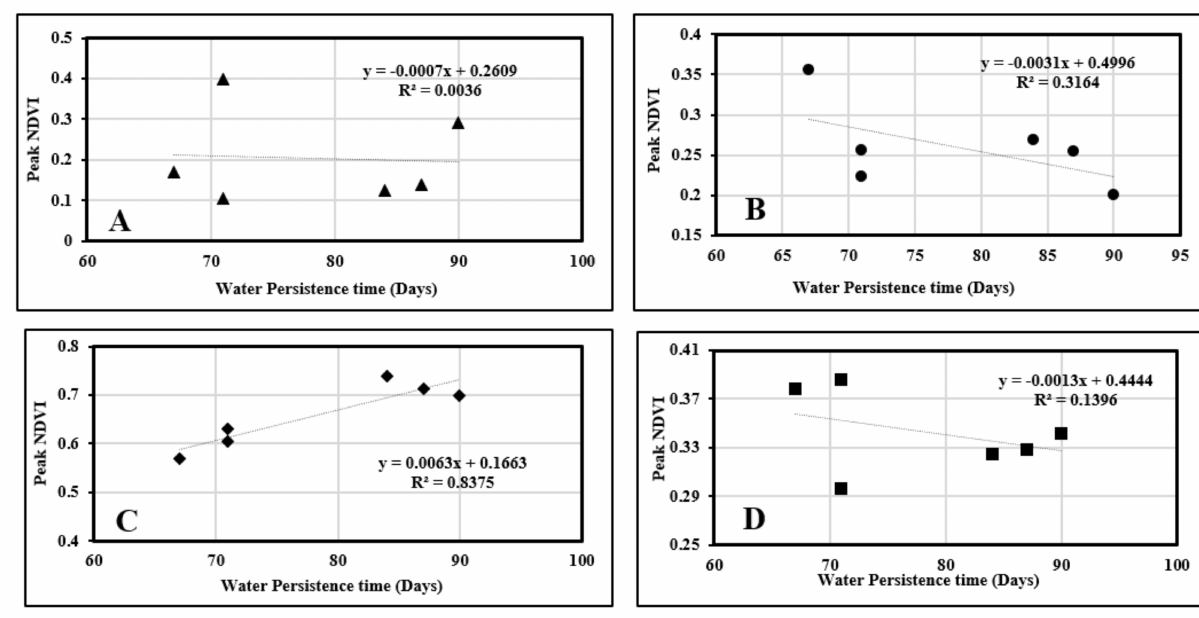
Figure 10. Regression analyses of the daily water level and peak NDVI value in different areas. ( A ) for the highly active continuously inundated floodplain belt, ( B ) for the highly active frequently inundated floodplain belt, ( C ) for the static regularly inundated floodplain belt and ( D ) for the static extremely rarely inundated floodplain